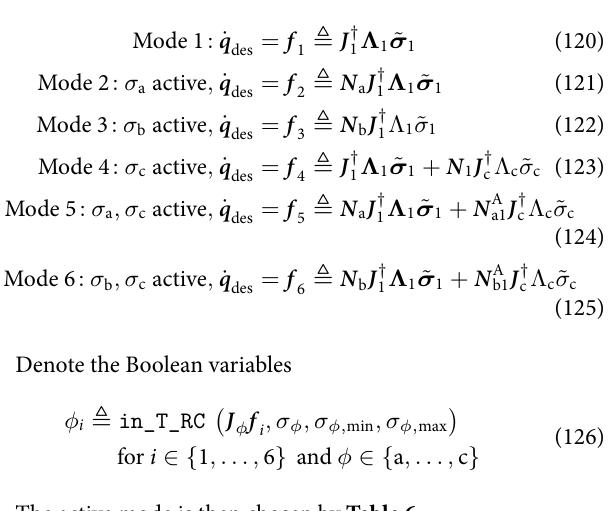
FOVisimplementedasalow-priorityset-basedtask σ c = σ FOV , with a maximum value to limit the error between a and a des .